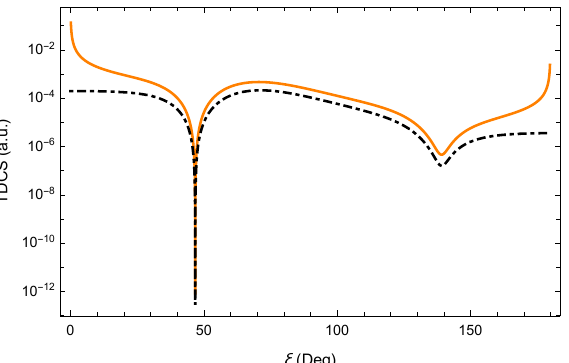
Figure 6. TDCS on a log (ln) scale versus the polar angle, ξ , for positron-impact ionization of hydrogen at 100 eV with a gun angle of 56.13 ◦ . Comparison of the CB1 TDCS (dot-dashed black line) and the modified CB1 TDCS (solid orange line) results.